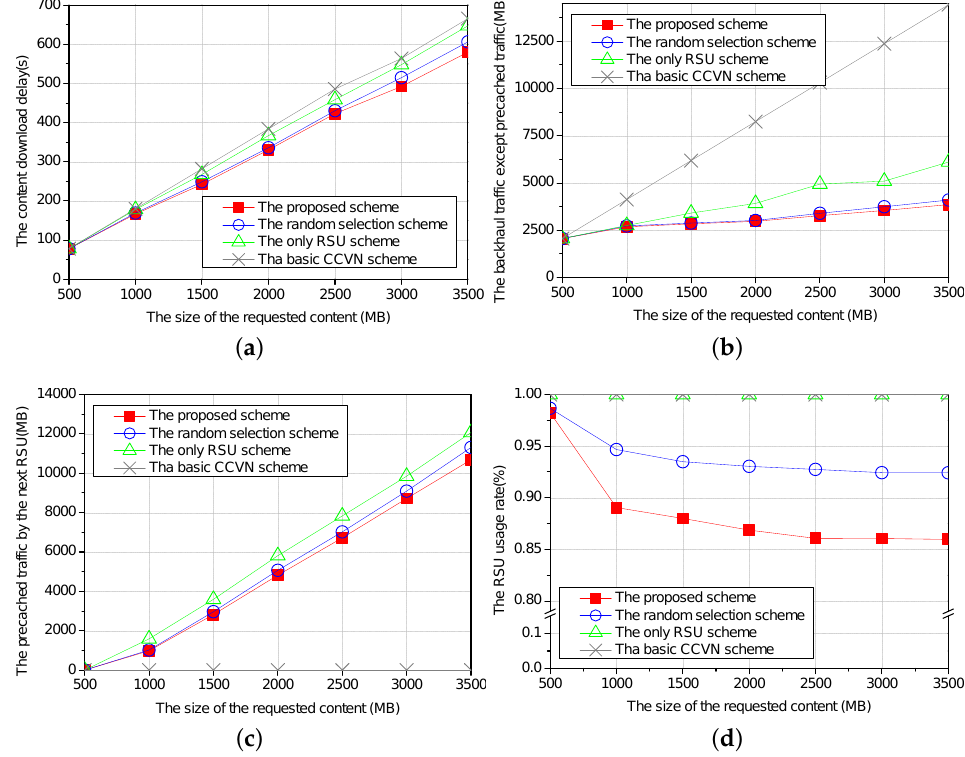
Figure 4. Simulation results for different sizes of the requested content : ( a ) the content download delay, ( b ) the backhaul traffic except precached traffic, ( c ) the precached traffic by next RSU and ( d ) the RSU usage